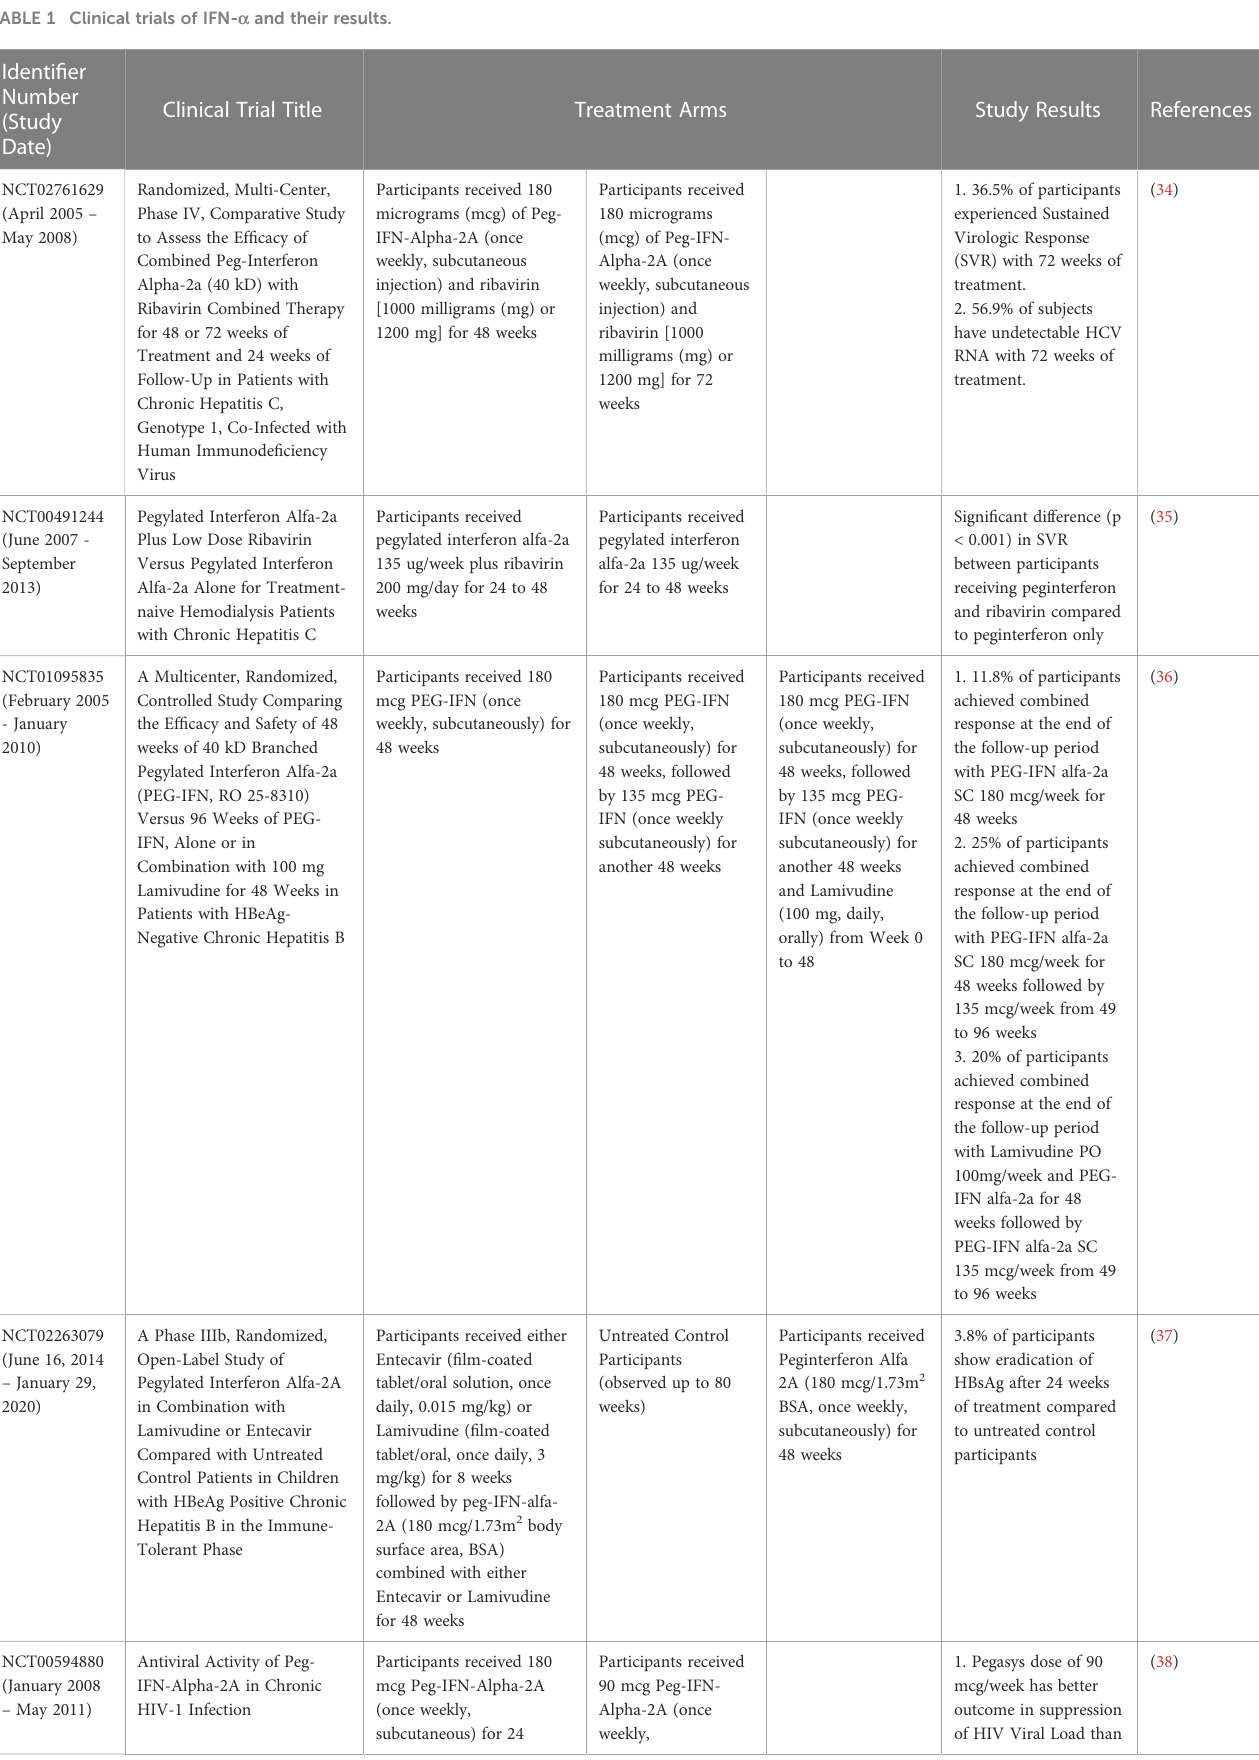
TABLE 1 Clinical trials of IFN- a and their